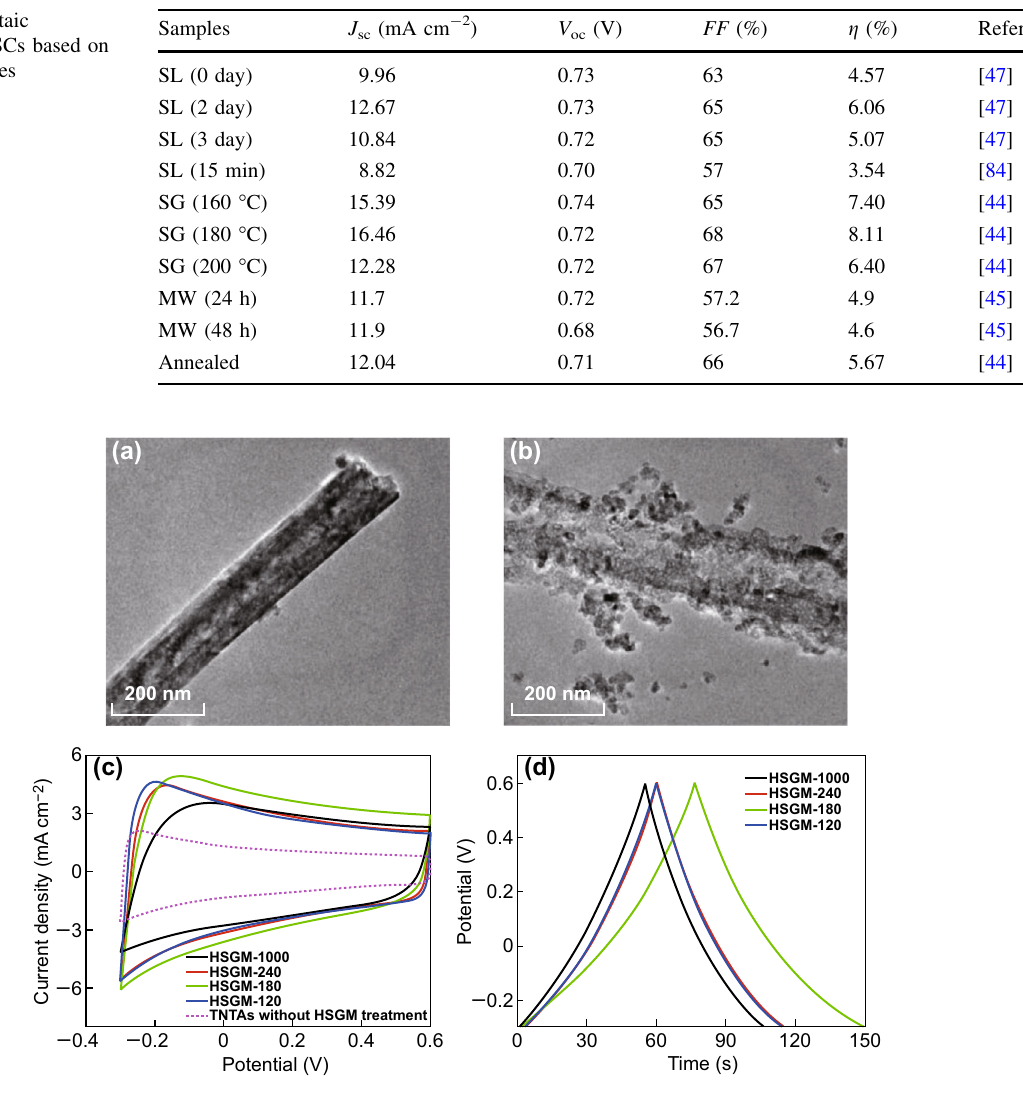
Fig. 15 Typical TEM images of the TNTs for a as-anodized and b after HSGM (hydrothermal solid–gas method) treatment with 120 l L water put into a 50 mL Teflon autoclave. c Cyclic voltammograms of the TNTAs without HSGM treatment and TNTAs treated by HSGM under different vapor pressures at a scan rate of 100 mV s - 1 . d Galvanostatic charge–discharge (GCD) curves of the HSGM-treated TNTAs at a current density of 0.5 mA cm - 2 . HSGM-120, 180, 240, 1000 represent the different water content in the Teflon autoclave, which leads to the different vapor pressures [53]. Copyright (cid:2) 2017 Elsevier